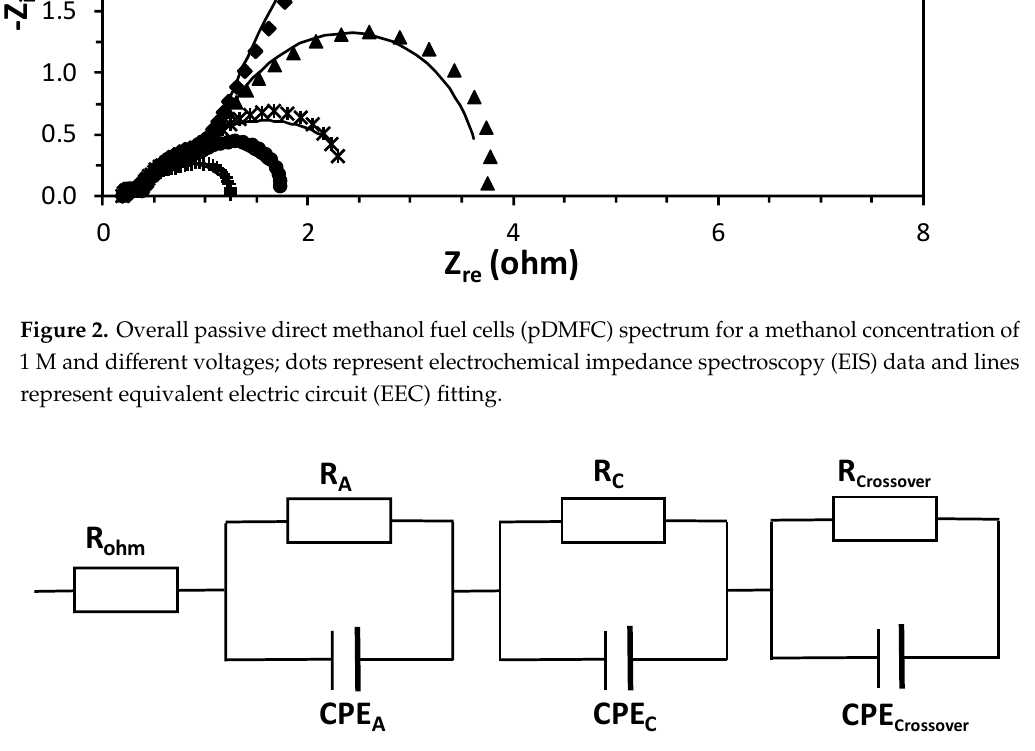
Figure 3. Equivalent electric circuit (EEC).